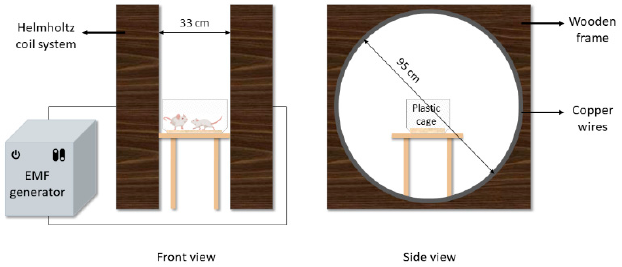
Figure 2. EMF exposure system. EMF; electromagnetic field.